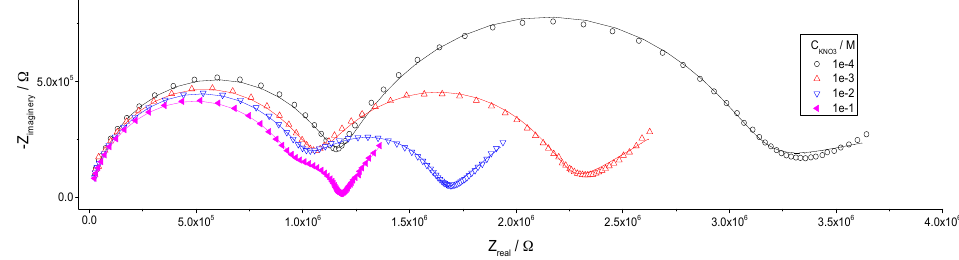
Figure 4. Impedance spectra of ISE 2 in contact with KNO 3 solutions with concentrations from 10 − 4 to 0.1 M. Symbols refer to experimental data, solid lines to fitted spectra.